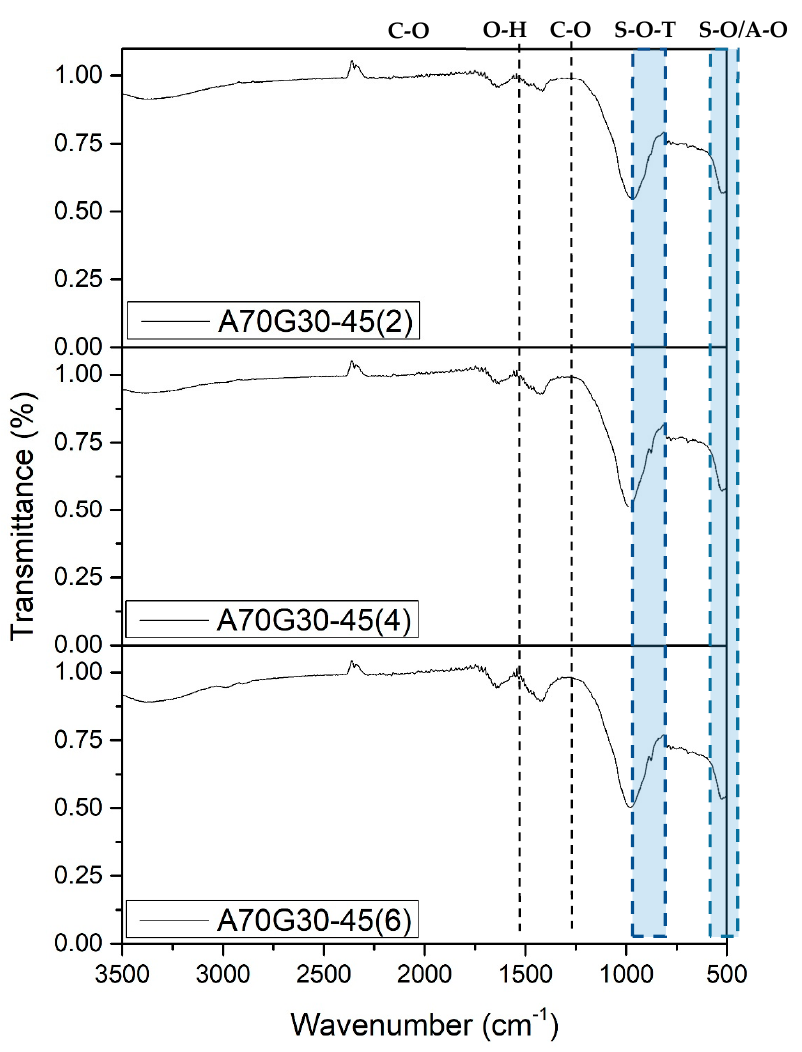
Figure 9. FTIR spectrum of AG geopolymer mortar after 28 days of curing.